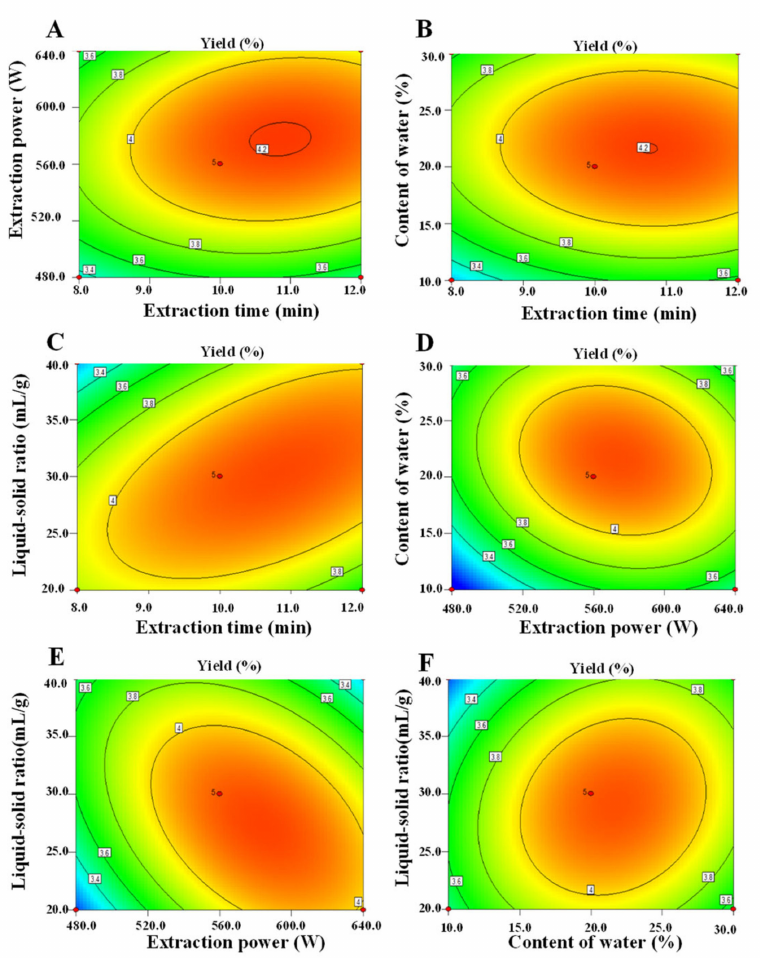
Figure 3. Two-dimensional contour plots of microwave-assisted deep eutectic solvent extraction. A – F , in- teractions among extraction time, extraction power, content of water, and liquid–solid ratio,